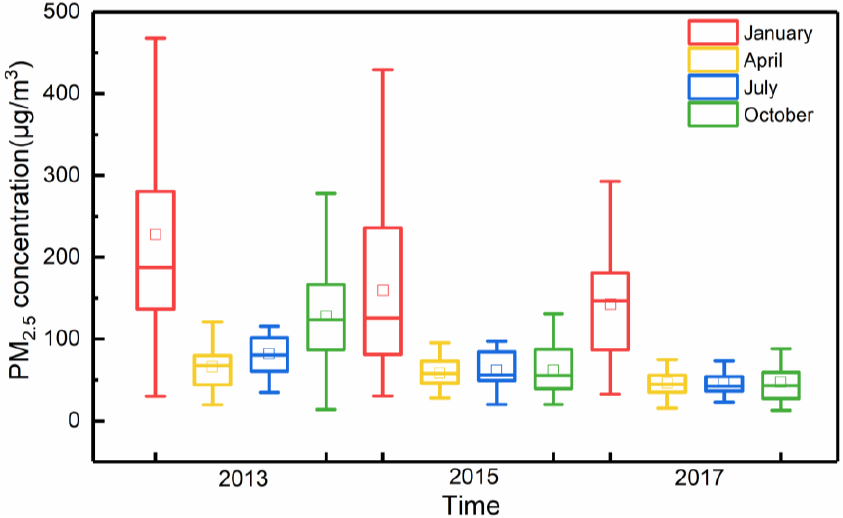
Figure 2. Monthly average mass concentration of PM 2.5 .